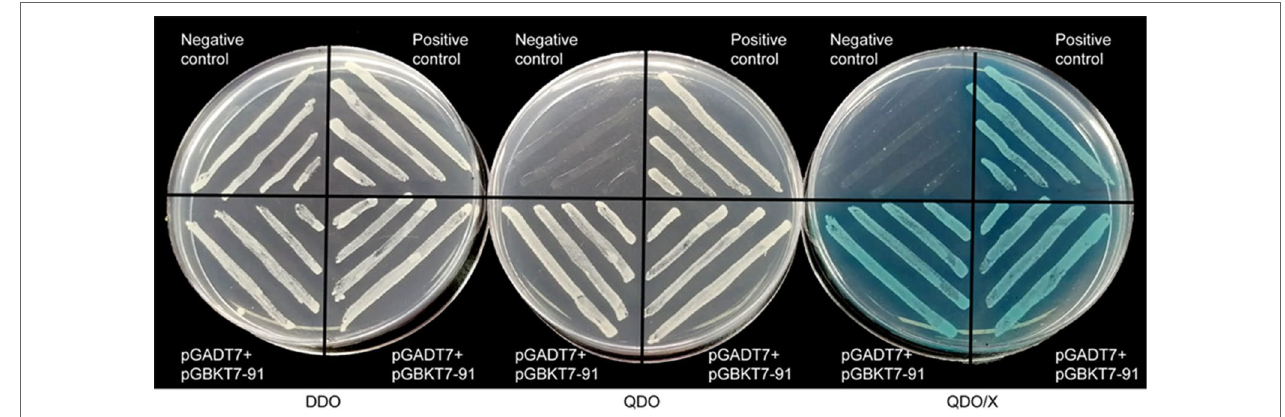
FIGURe 2 | Transcriptional activity of GhWRKY91 in Y2HGold yeast cells. Yeast cells were assayed on DDO (SD-Trp-Leu), QDO (SD-Trp-Leu-His-Ade) and QDO/X (SD-Trp-Leu-His-Ade/X-a-Gal) medium. The combination of the pGADT7-large T and pGBKT7-p53 plasmids was used as a positive control. The combination of the